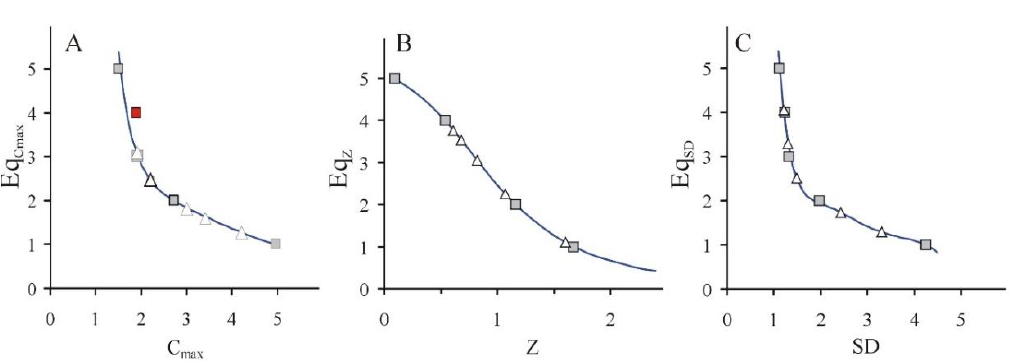
Figure 3. Relationships between: ( A ) maximum macrophyte depth C max (Equation (4)); ( B ) colonization index Z (Equation (5)) and ( C ) Secchi disc visibility SD (Equation (6)) in ecological status classes on a scale of 1–5 in Polish stratified lakes (marked with squares; orange square—point eliminated from analyses) and five lakes in the Wel Landscape Park (marked with triangles). Source of data: Ciecierska et al. [9]; Kolada et al. [17].